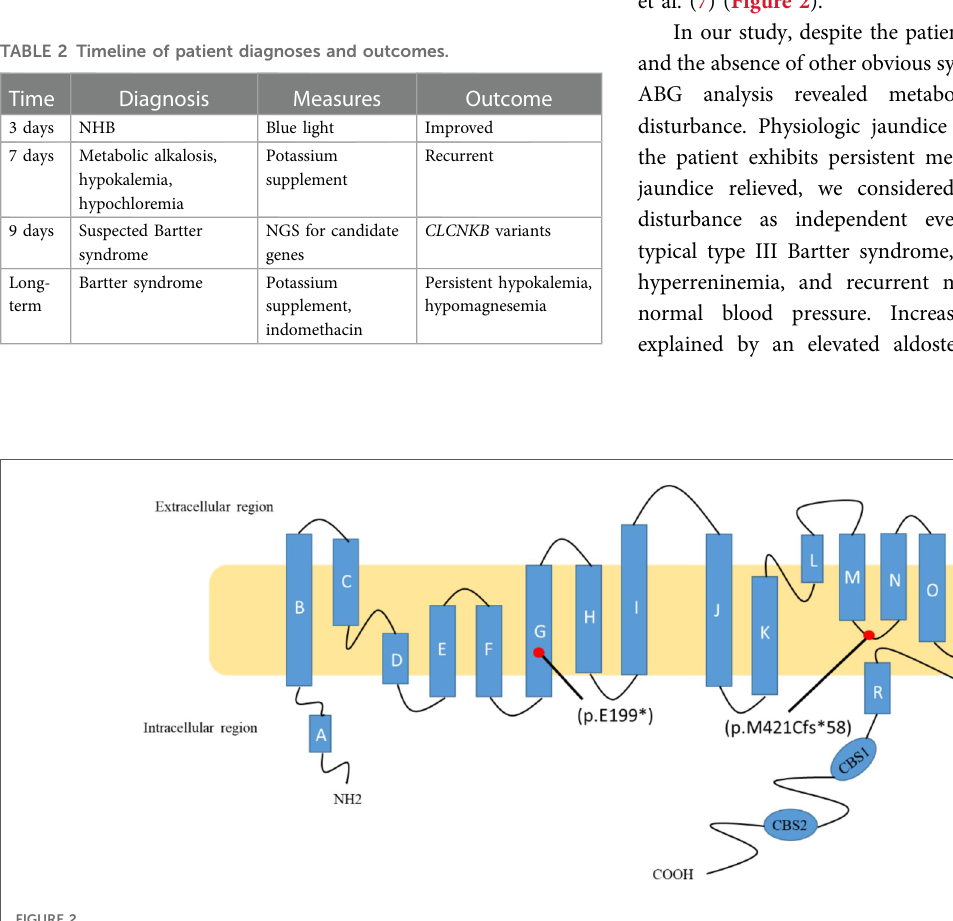
FIGURE 2 Schematic diagram of ClC-Kb and localization of two mutations. The c.1257delC (p.M421Cfs*58) mutation is located in the linker between helices M and N, while the c.595G>T (p.E199*) mutation is found in the middle of helices